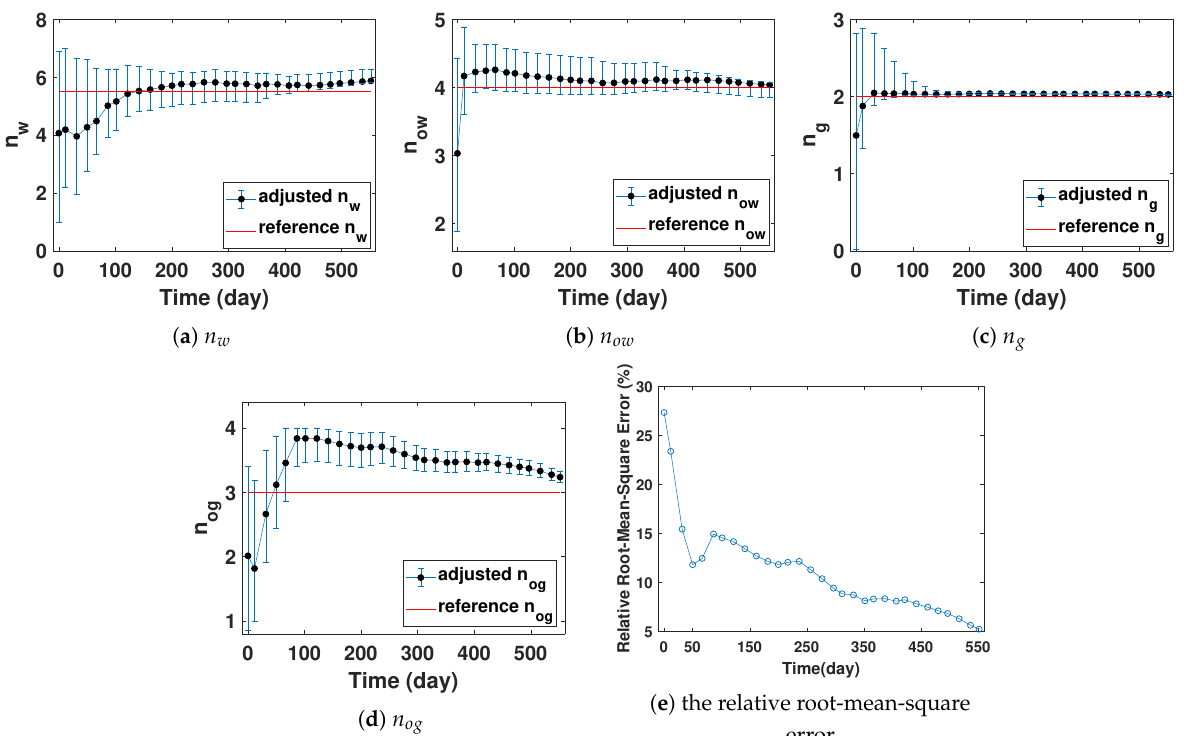
Figure 6. The reference values, the adjusted parameters and the relative root mean square errors the at different time with known endpoints. The red line denotes the true reference (true) value of a parameter. The black dot denotes the mean of an ensemble. The blue bar denotes the maximum and minimum deviations from the mean. ( a ) n w ; ( b ) n ow ; ( c ) n g ; ( d ) n og ; ( e ) the relative root mean square